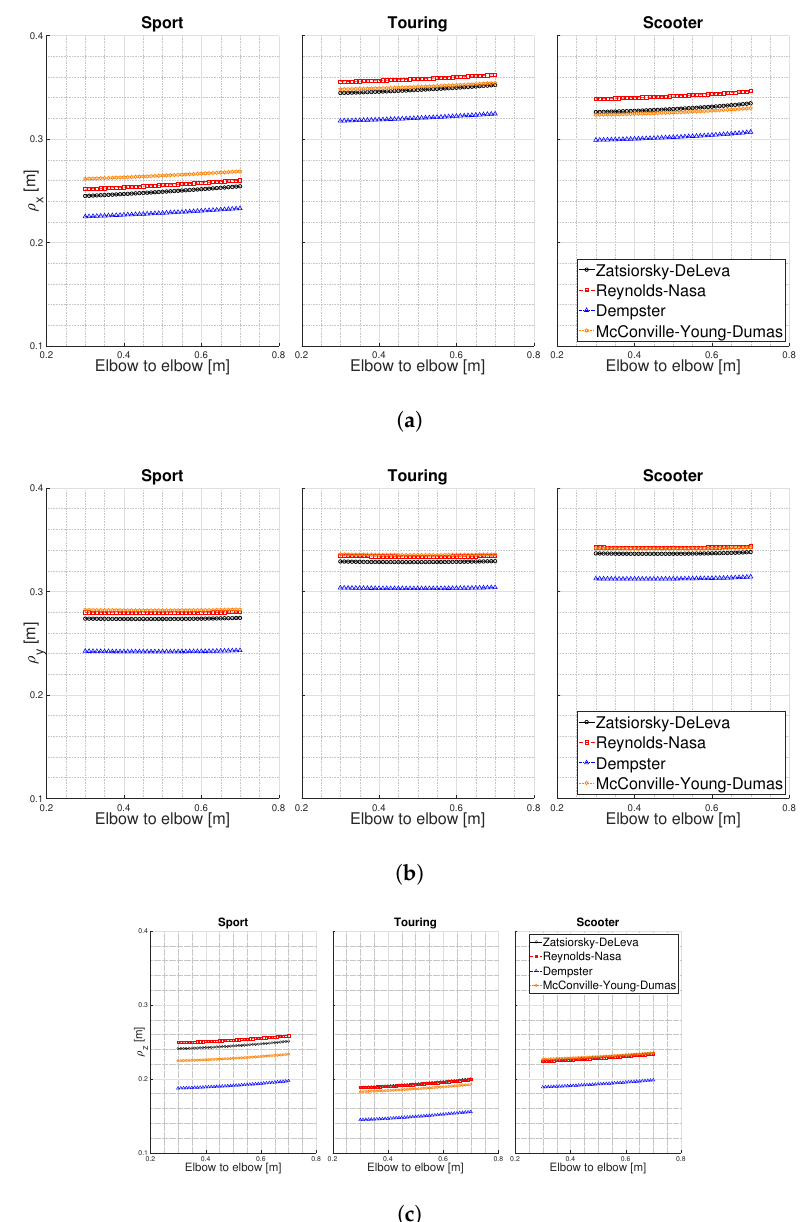
Figure 7. Roll ρ x ( a ), pitch ρ y ( b ), and yaw ρ z ( c ) gyration radii as a function of elbow